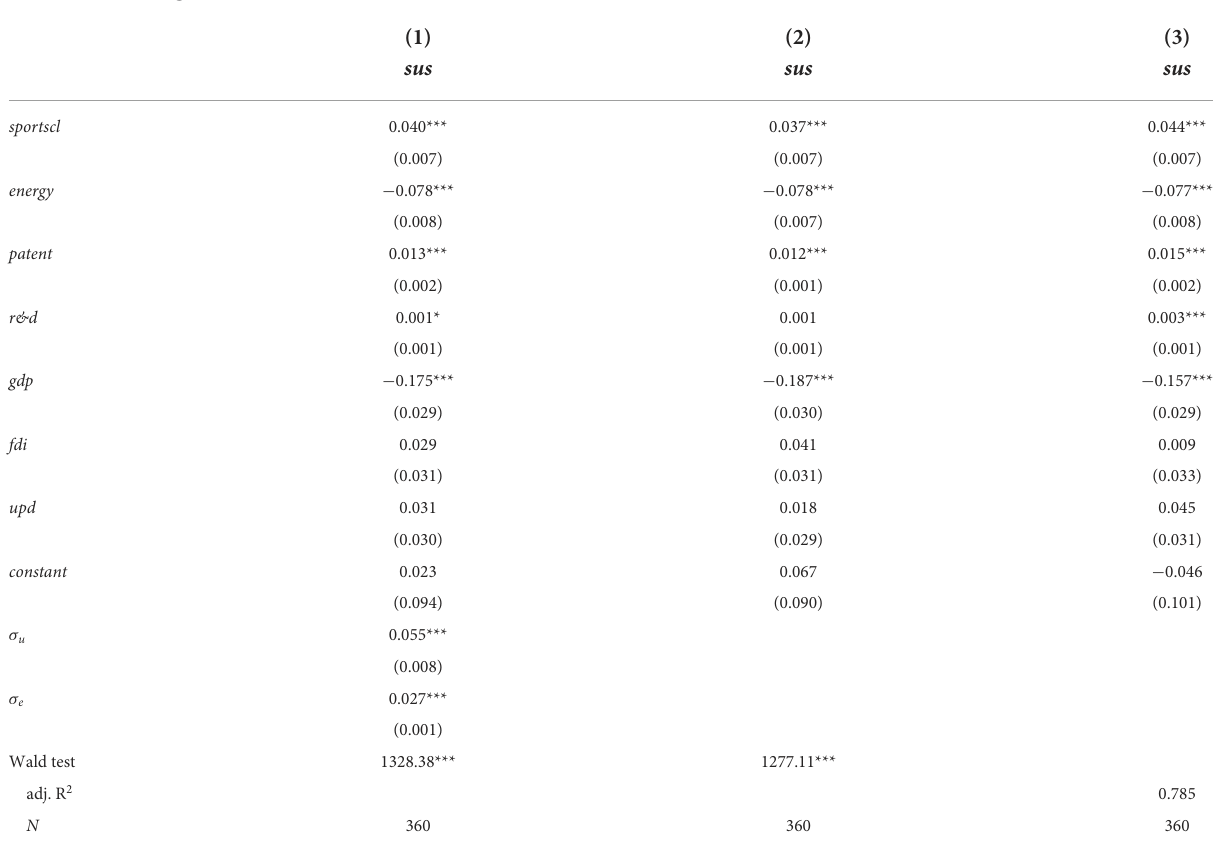
TABLE 3 Baseline regression